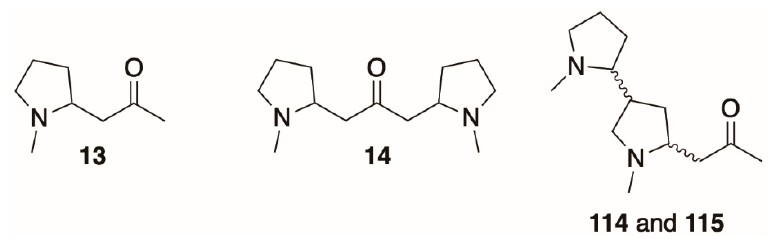
Figure 11. N -methylpyrrolinium ion ( 17 )-derived pyrrolidine alkaloids. Cuscohygrine ( 13 ) results from condensation of oxobutanoate ester 18 (Figure 6) with